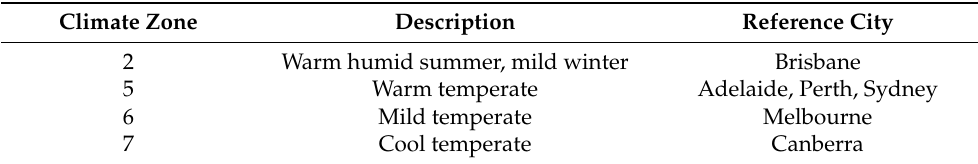
Table 4. Description of the climatic zone according to [6].